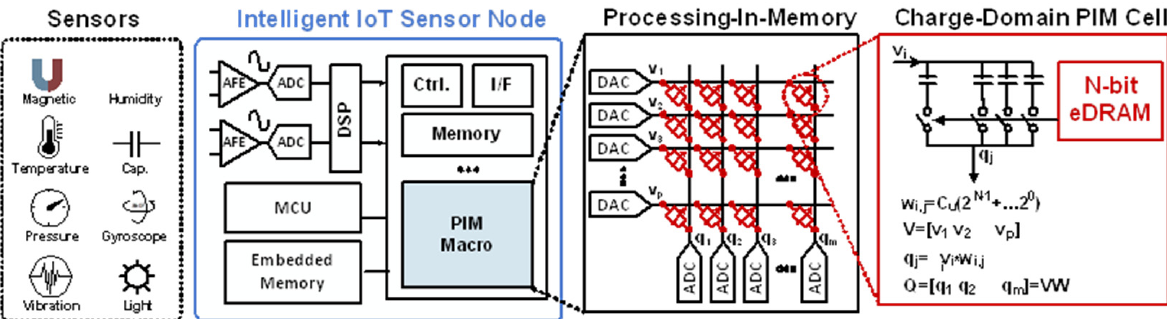
Figure 1. Conceptual block diagram of eDRAM-based PIM used for intelligent IoT sensor nodes.